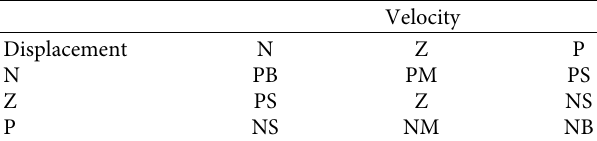
Figure 2: Input membership functions.